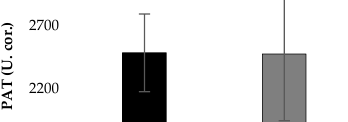
Figure 3. Oxidative stress marker on plasma antioxidant capacity (PAT) between groups.